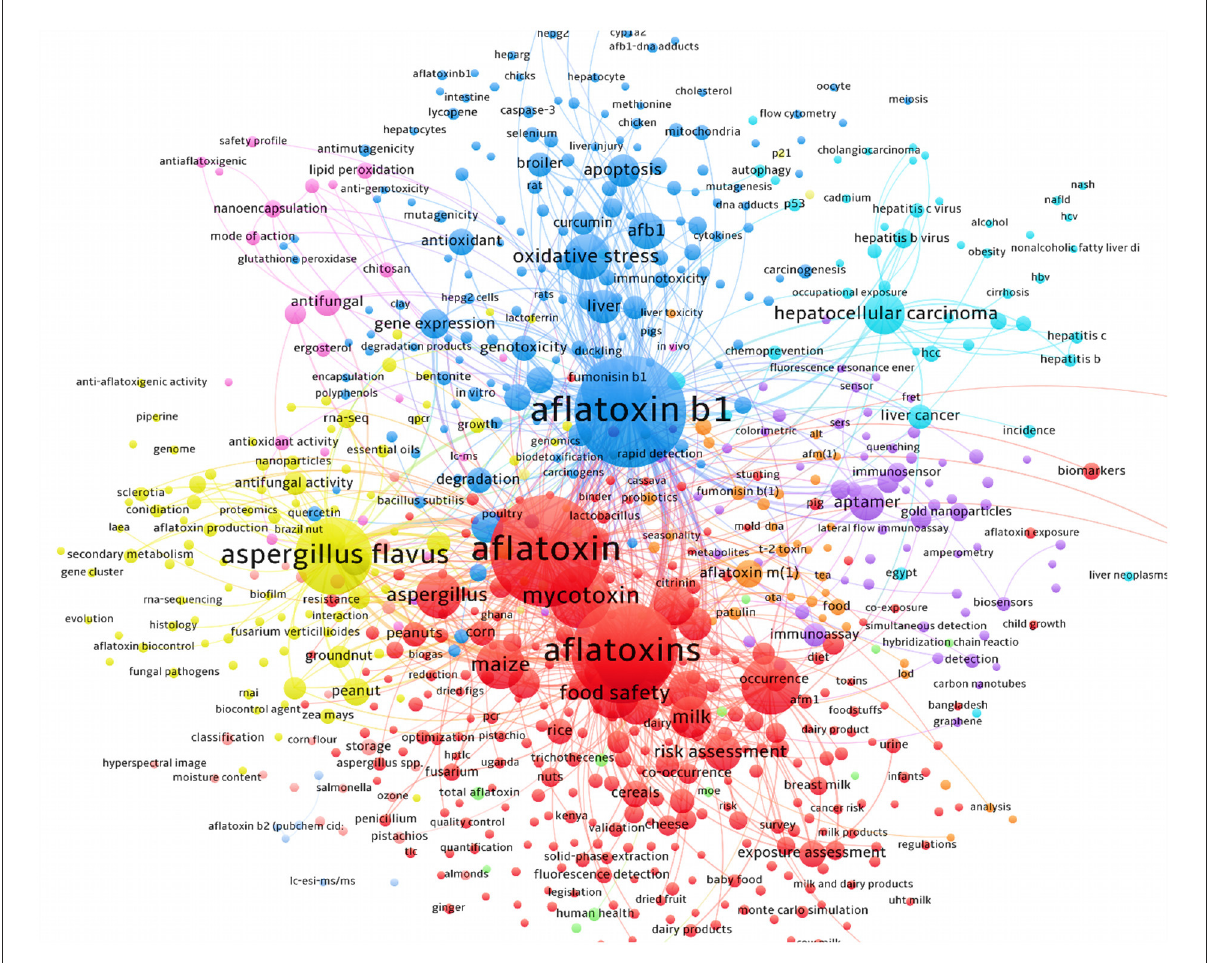
FIGURE6 The detailed bibliometric network of studies on AFB1 in association with relevant